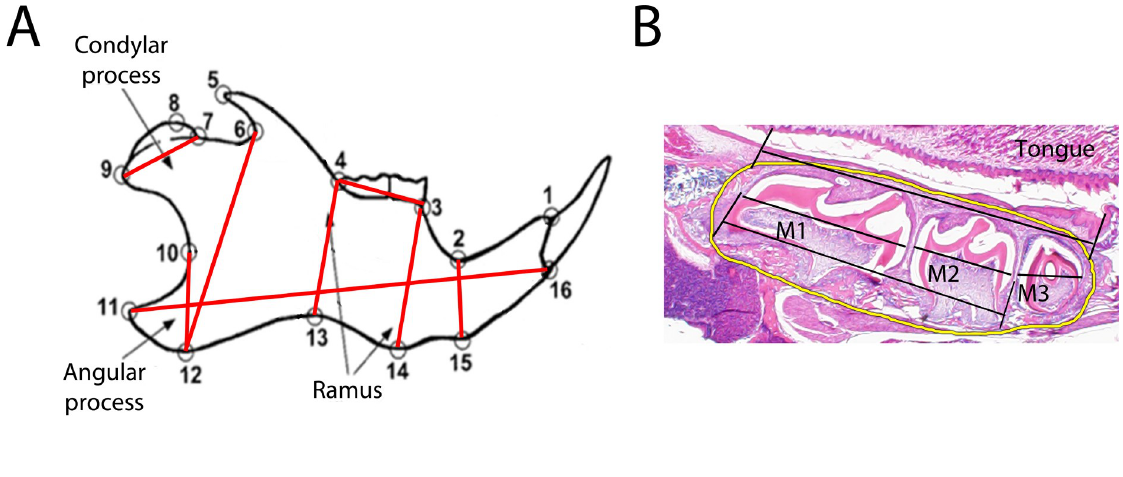
Fig 1. Mandible landmarks and measurement schematics. A) Cephalometric landmarks on murine mandible used for measurements. Dark lines between points indicate measures used in this analysis. Schematic modified from Klingenberg et al. 2004. B) Representative hematoxylin and eosin stained molars with lengths measured indicated with black lines, area of interest surrounding molars indicated in yellow, and molars 1–3 identified.